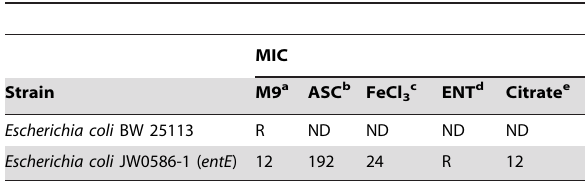
Table 3. MIC of pyochelin in the presence of selected